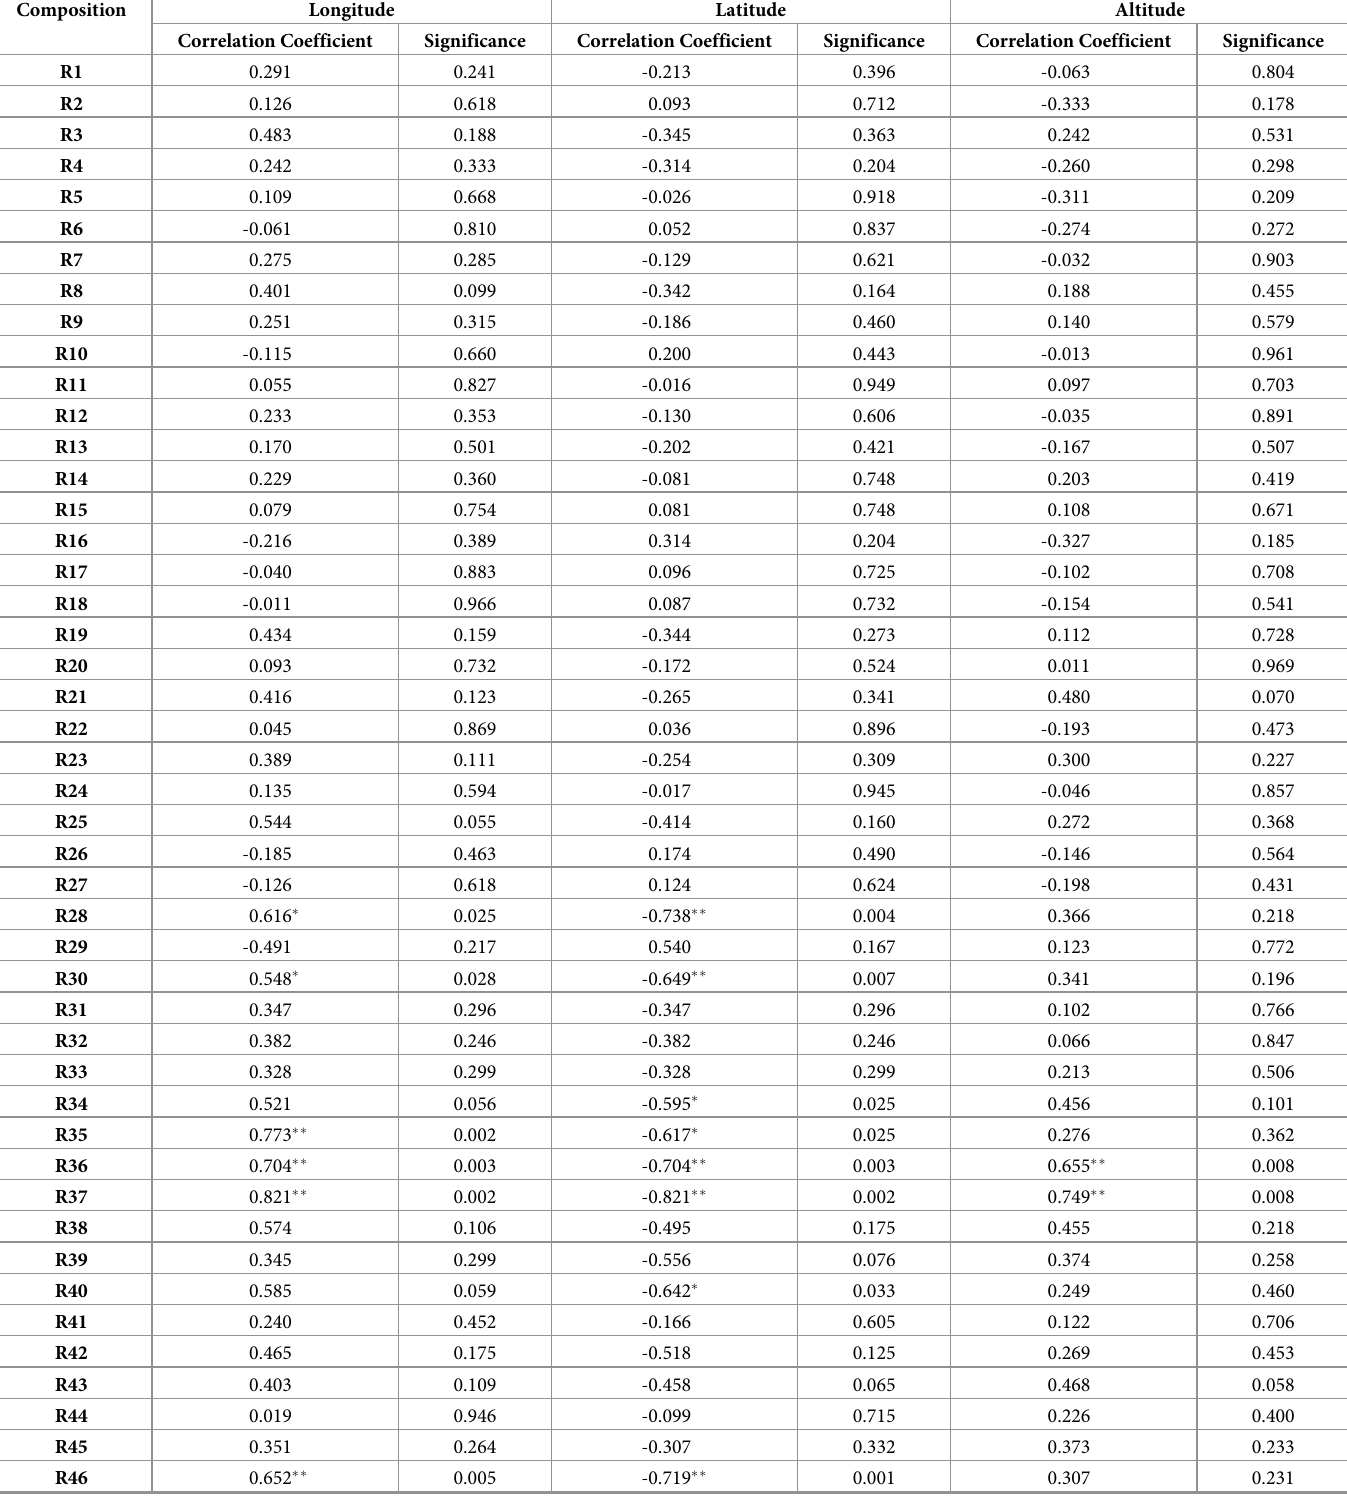
Table 9. Pearson correlation test table for the influence of longitude, latitude and altitude on